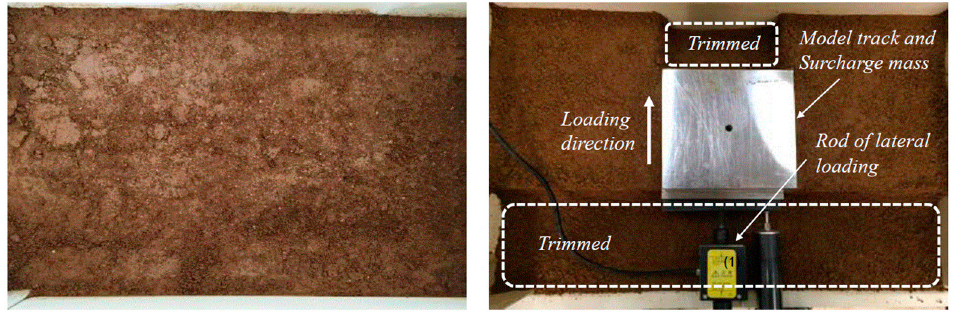
Figure 5. Preparation of model ground (top view): (left) before trimming, and (right) after trimming. Appl. Sci. 2020 , 10 , 3175